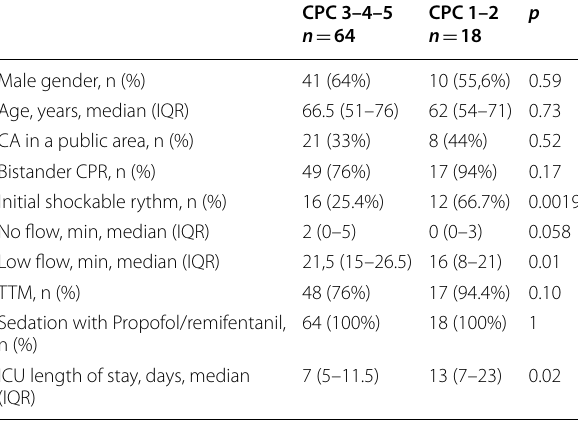
Table 1 Patient’s